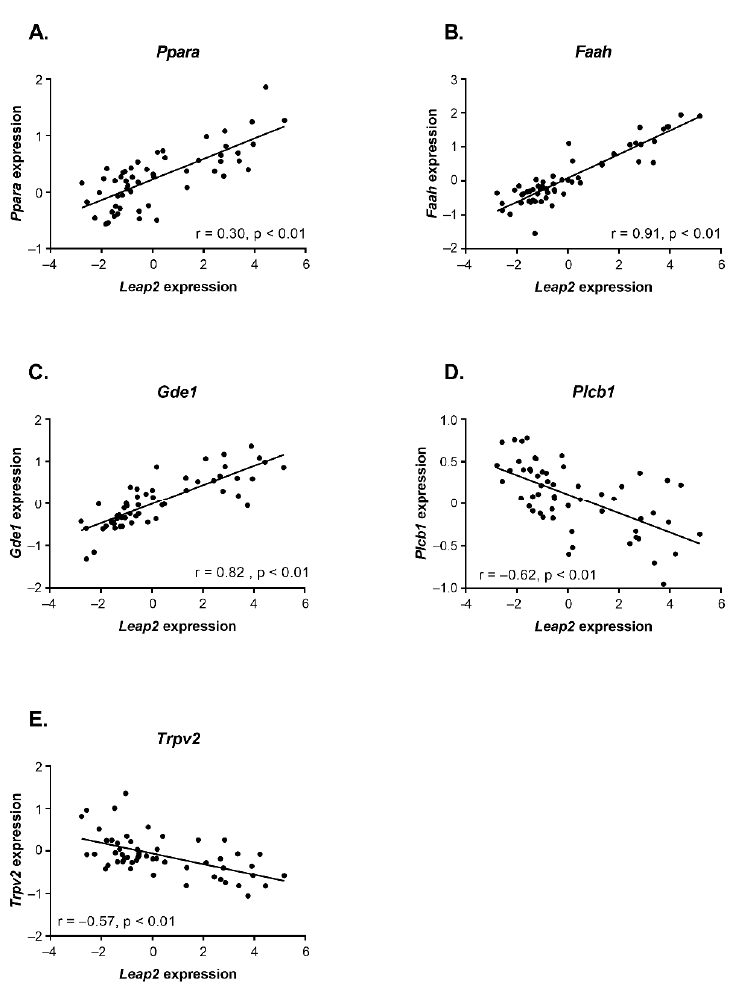
Figure 7. Correlation between the mRNA expression levels of Leap2 and those of ( A ) Ppara , ( B ) Faah , ( C ) Gde1 , ( D ) Plcb1 and ( E ) Trpv2 in the ileum of HFHS-fed mice. The figure shows scatterplots with regression lines. Pearson correlation coefficients (r) and p -values are shown in graphs (n = 54–56). Data were obtained using the 2- ΔΔ Ct method relative to the Tbp (TATA-binding protein) house- keeping gene (RT-qPCR).